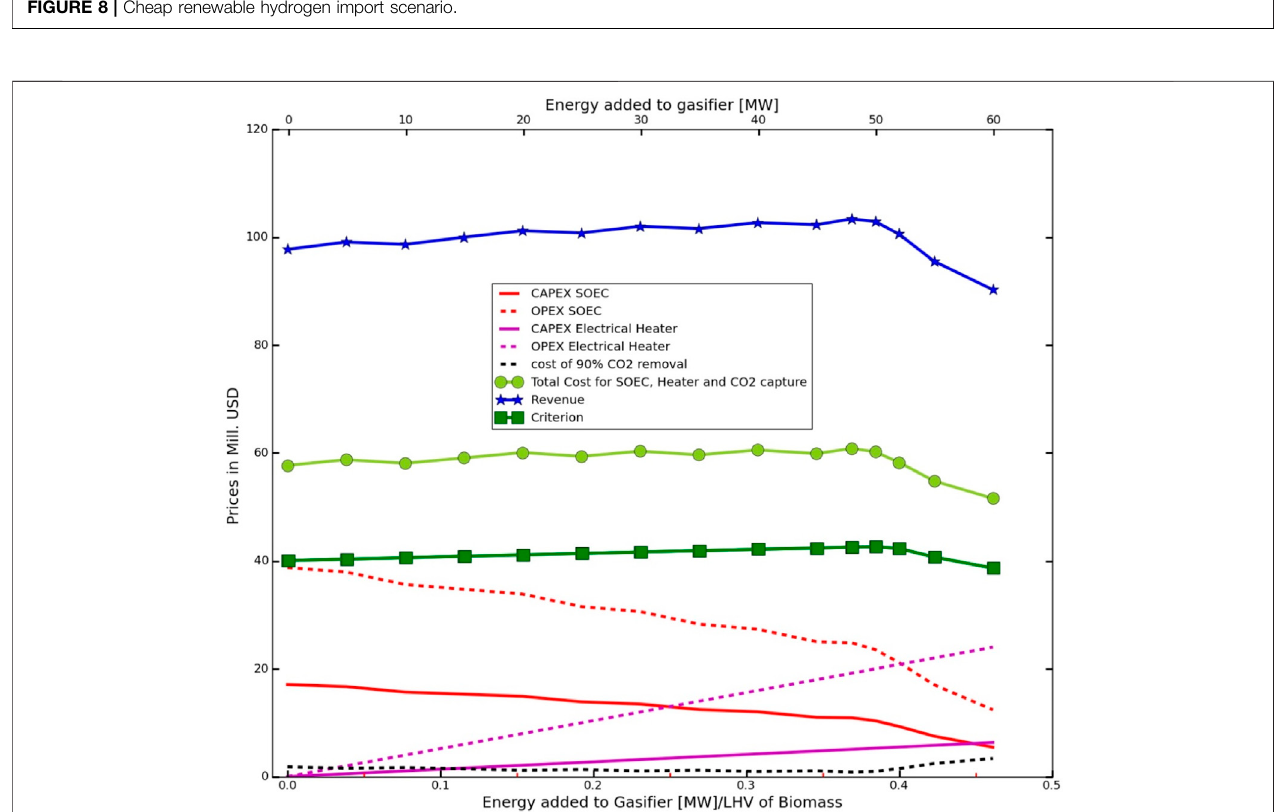
FIGURE 9 | Analysis of cost breakdown for the SOEC